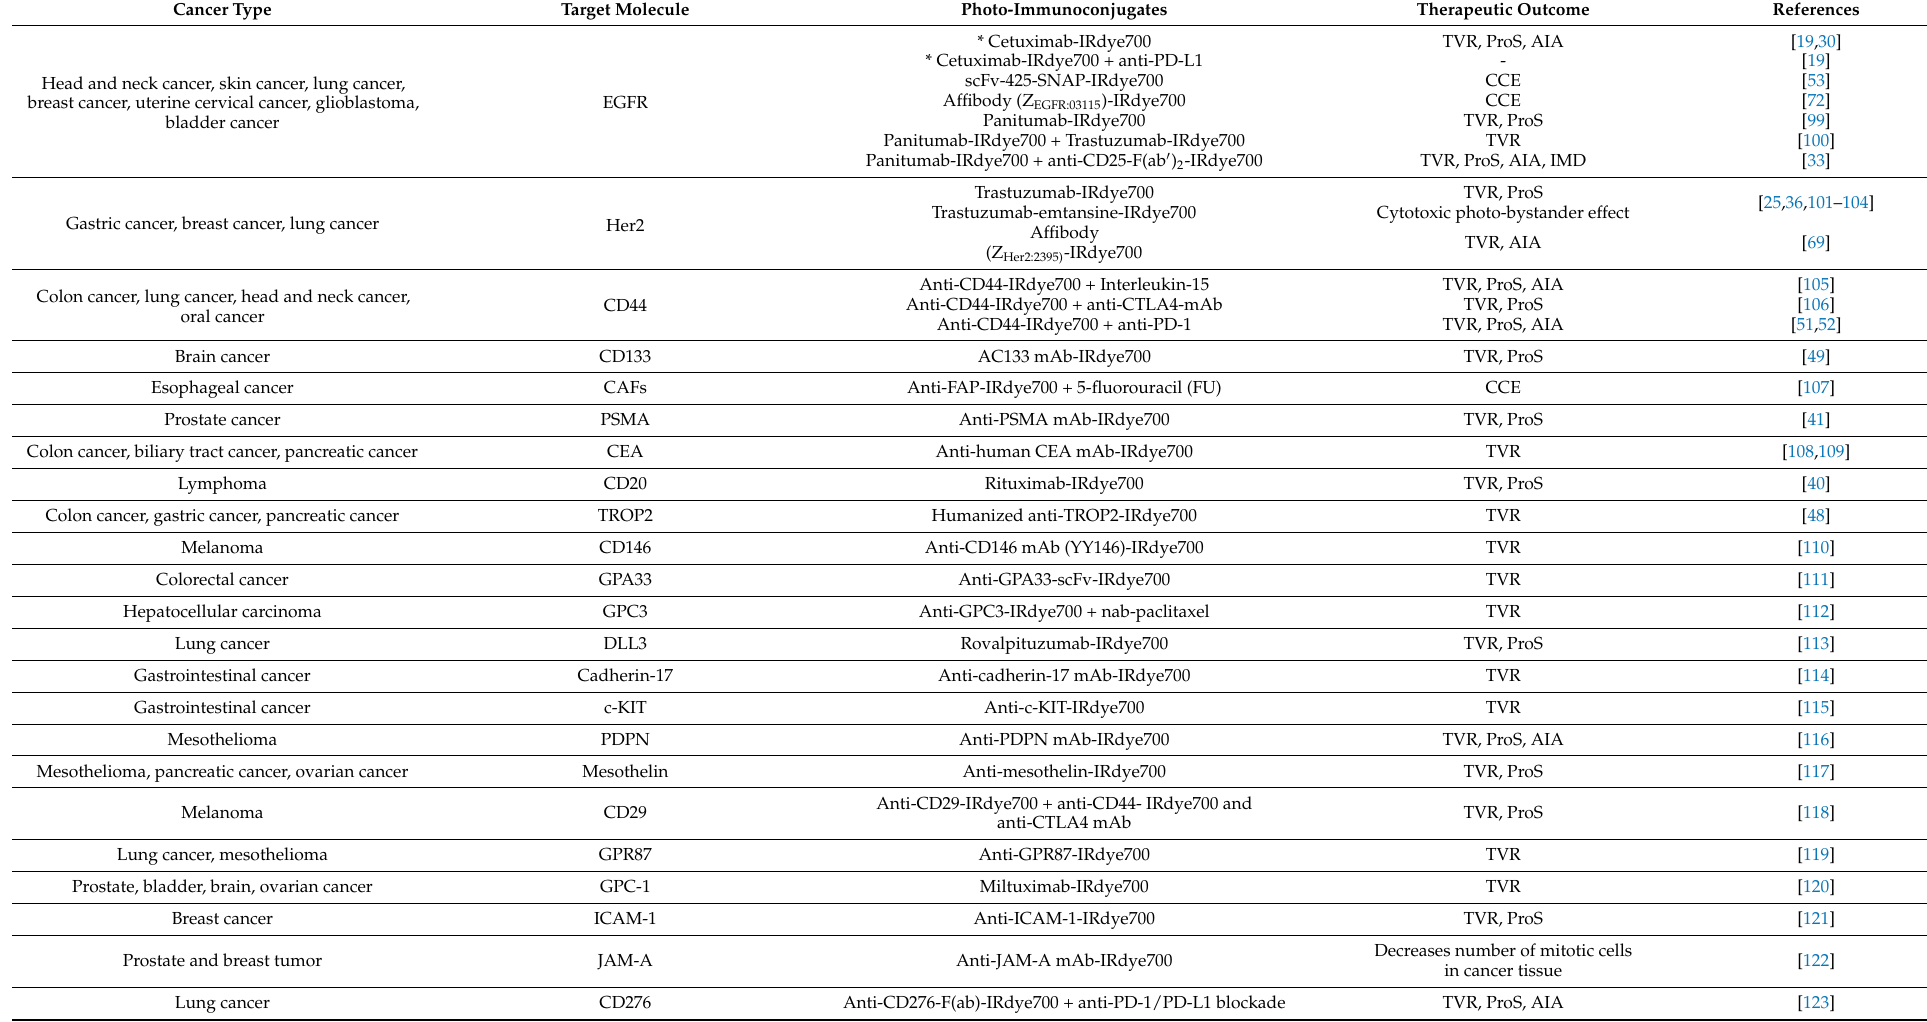
Table 1. NIR-PIT agents and their clinical and preclinical